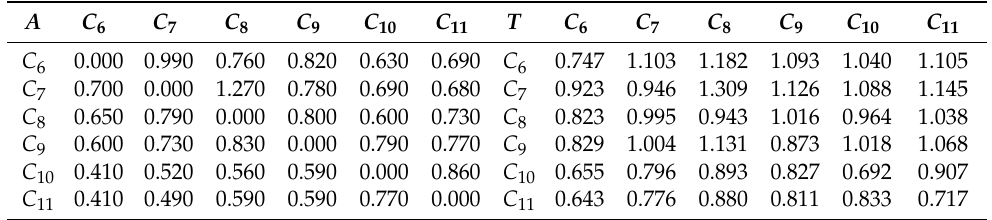
Table 6. The direct and total influence relations matrix of D 2- gamification.